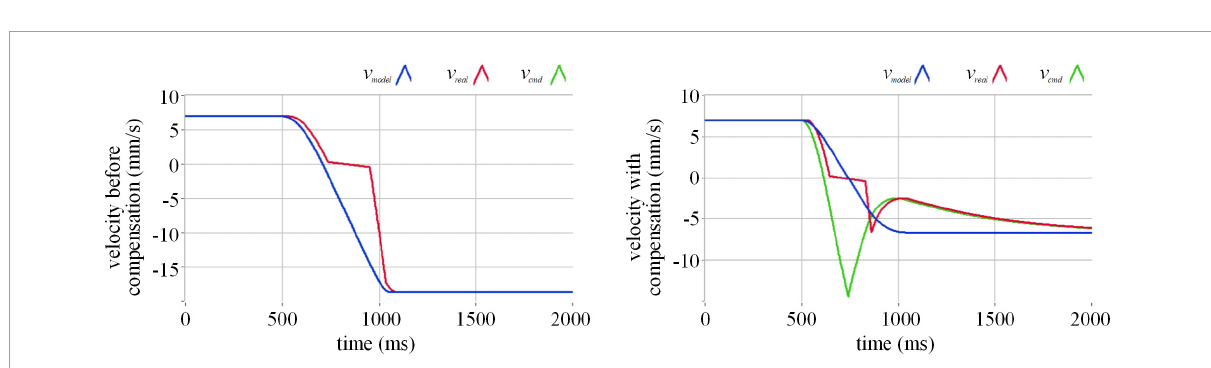
FIGURE7 Effect of actuation compensation at a velocity of 7 mm/s in the simulation. Where the blue line represents the command velocity, the red line the execution velocity, and the green line the command velocity after the